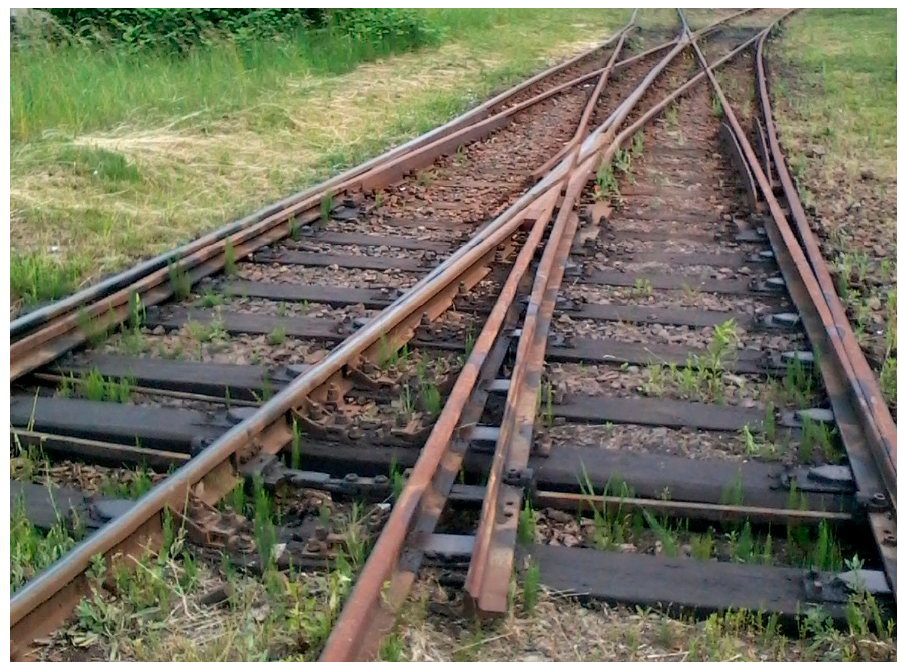
Figure 5. Outside slip turnout with blades outside the quadrilateral turnout of Rkpd izew .